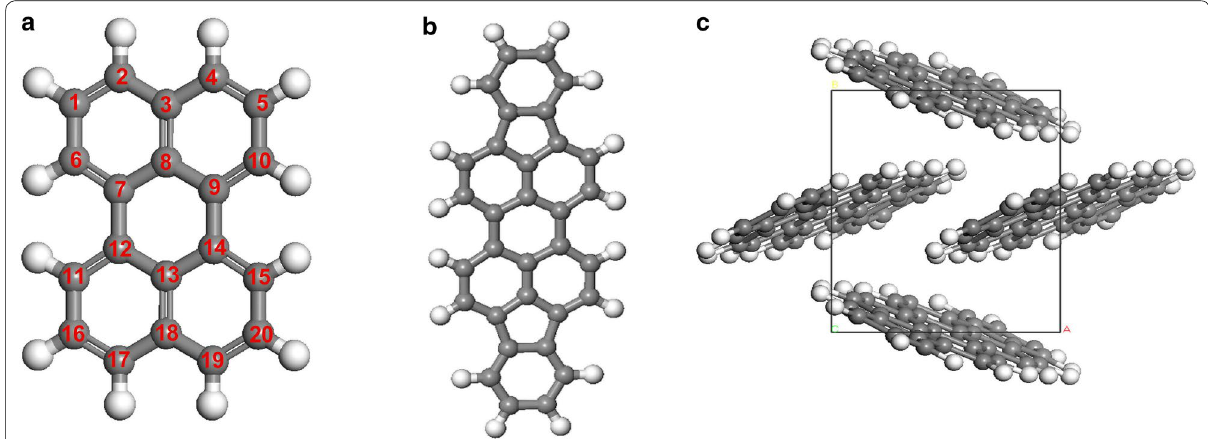
Fig. 1 Graphical view of a isolated perylene molecule, b DIP molecule and c DIP single crystal where grey and white balls represent carbon and hydrogen